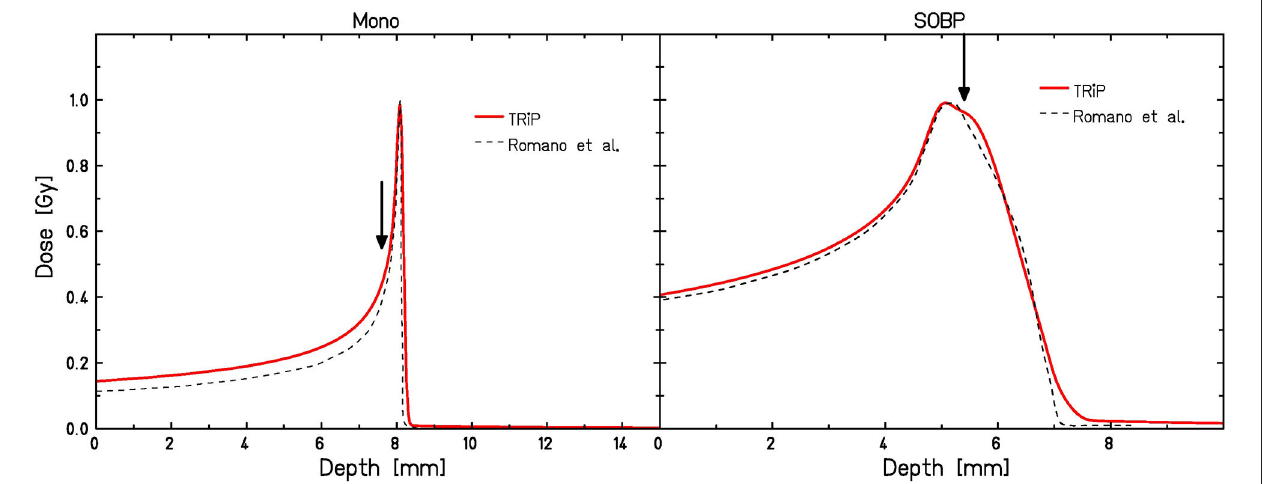
FIGURE 1 | Depth dose distributions for monoenergetic (left) and SOBP (right) carbon ion irradiation according to TRiP calculations used in this paper as compared to those reported by Romano et al. [49]. Irradiation positions are marked by arrows.